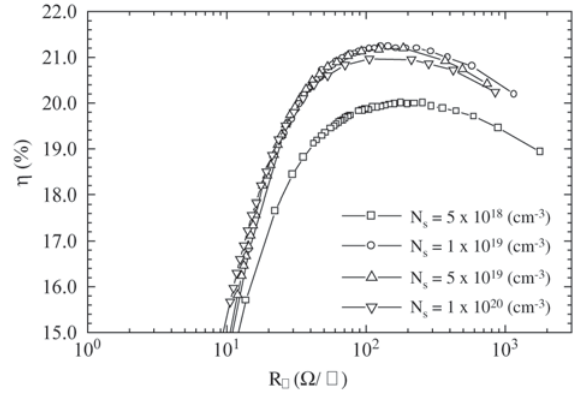
Figure 6. Short-circuit current density, J sheet resistivity, R and surface doping level, N (cid:0) type emitter solar cells.